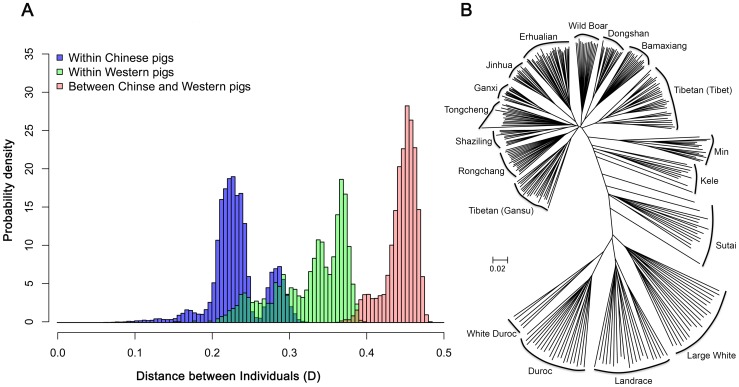
Genetic diversity within and between Chinese and Western pigs.(A) The genetic distance (D) between pairs of animals. Blue bars represent D within Chinese pigs; green bars represent D within Western pigs; red bars denote D between Chinese and Western pigs. (B) The neighbor-joining tree of the tested populations based on genome-wide allele sharing.